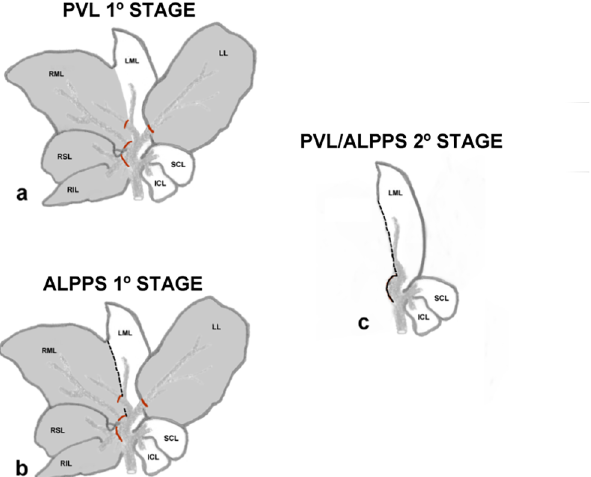
Fig 1. Schematic representation of the PVL and ALPPS procedures on the rat liver. ( a ) For the PVL, selective ligation (dark areas and red lines) of the portal flow was assessed on the right superior (RSL), right inferior (RIL), left (LL), and the right portion of the middle lobes (RML), while the left portion of the middle lobe (LML), superior caudate (SCL), and inferior caudate (ICL) were not ligated. ( b ) Regarding the first stage of the ALPPS procedure, a complete in situ transection (black line) of the median lobe was also performed after the PVL. ( c ) After 8 days, the second stage comprised the excision of the ligated/atrophic